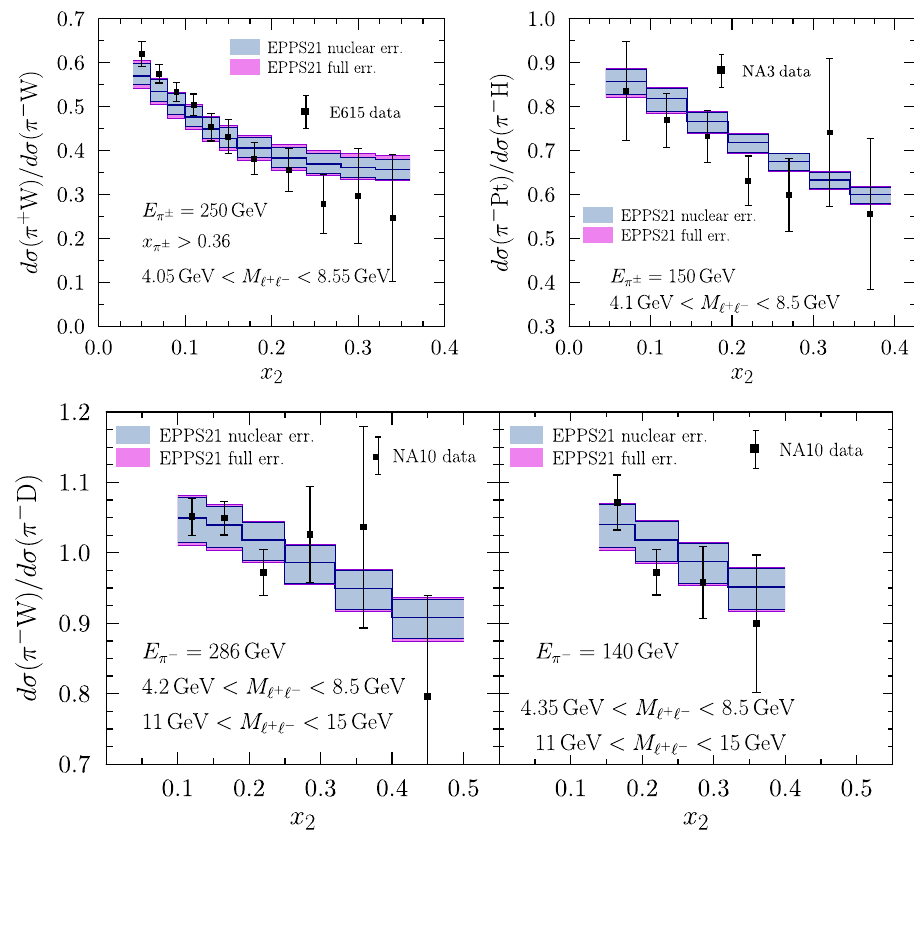
Fig. 26 The Drell–Yan ratios in π ± - A collisions from E615 [87], NA3 [88] and NA10 [89] compared with the EPPS21 analysis. The solid blue points show our central results, inner blue bands the nuclear uncertainties, and the purple bands the total